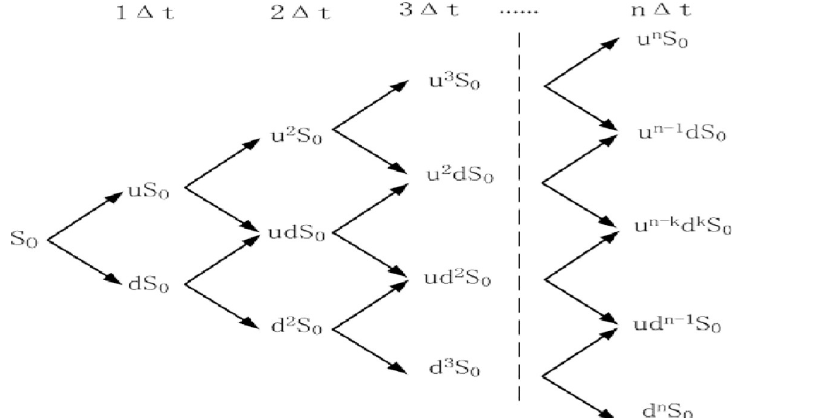
Fig 5. Schematic diagram of multi-stage binary tree. (Source: author’s work).